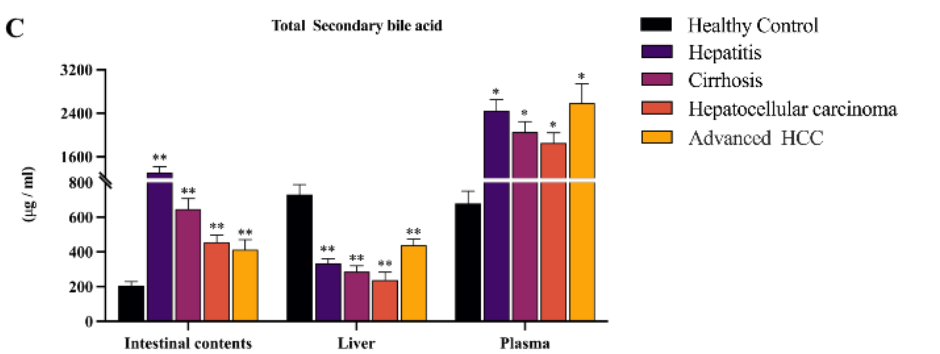
Figure 2. The variations of TBA, total primary BAs, and total secondary BAs in different specimens of DEN-induced HCC rats at healthy, hepatitis, cirrhosis, HCC, and advanced cancer stages. ( A ) TBA concentrations were significantly higher than blank controls in plasma, liver, and intestinal contents samples, and positively correlated with disease progression in plasma and liver. ( B ) The level change of total primary BAs was basically identical between plasma, liver, and intestinal contents, which were significantly elevated at all stages. ( C ) Total secondary BA levels were elevated in plasma and intestinal contents samples while significantly decreased in liver samples over the full course of the disease. The Figure indicates statistical significance compared with healthy controls by t -tests. * p < 0.05, ** p < 0.01.